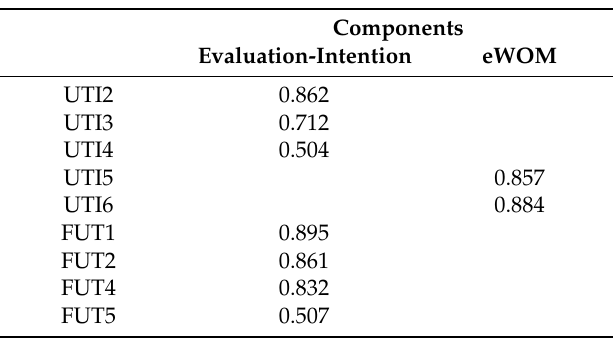
Table 10. Factorial weights, oblimin rotation